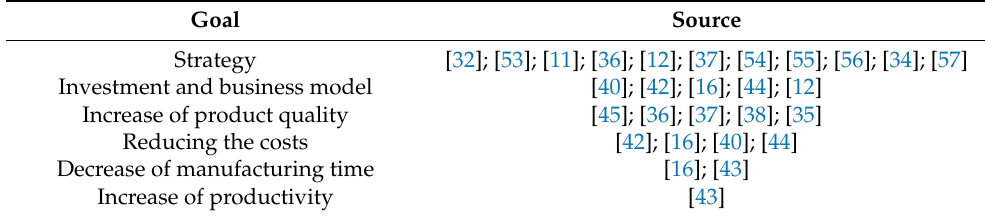
Table 1. Most common goals for the Industry 4.0 implementation in literature.